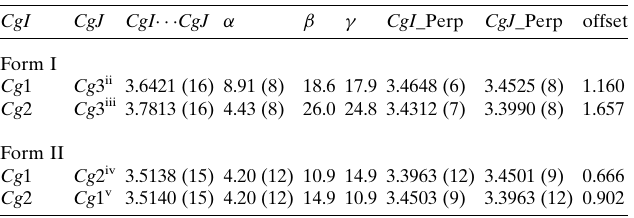
Table 2 (cid:2) – (cid:2) stacking interactions (A˚ , (cid:3) ) for Form I and Form II. Form I: Cg 1, Cg 2 and Cg 3 are the centroids of the N1/C1–C5, N2/C6–C10 and N3/C11–C15 rings, respectively. Form II: Cg 1 and Cg 2 are the centroids of the N1/C1–C5 and N2/C6–C10 rings, respectively (Fernandes et al. ,